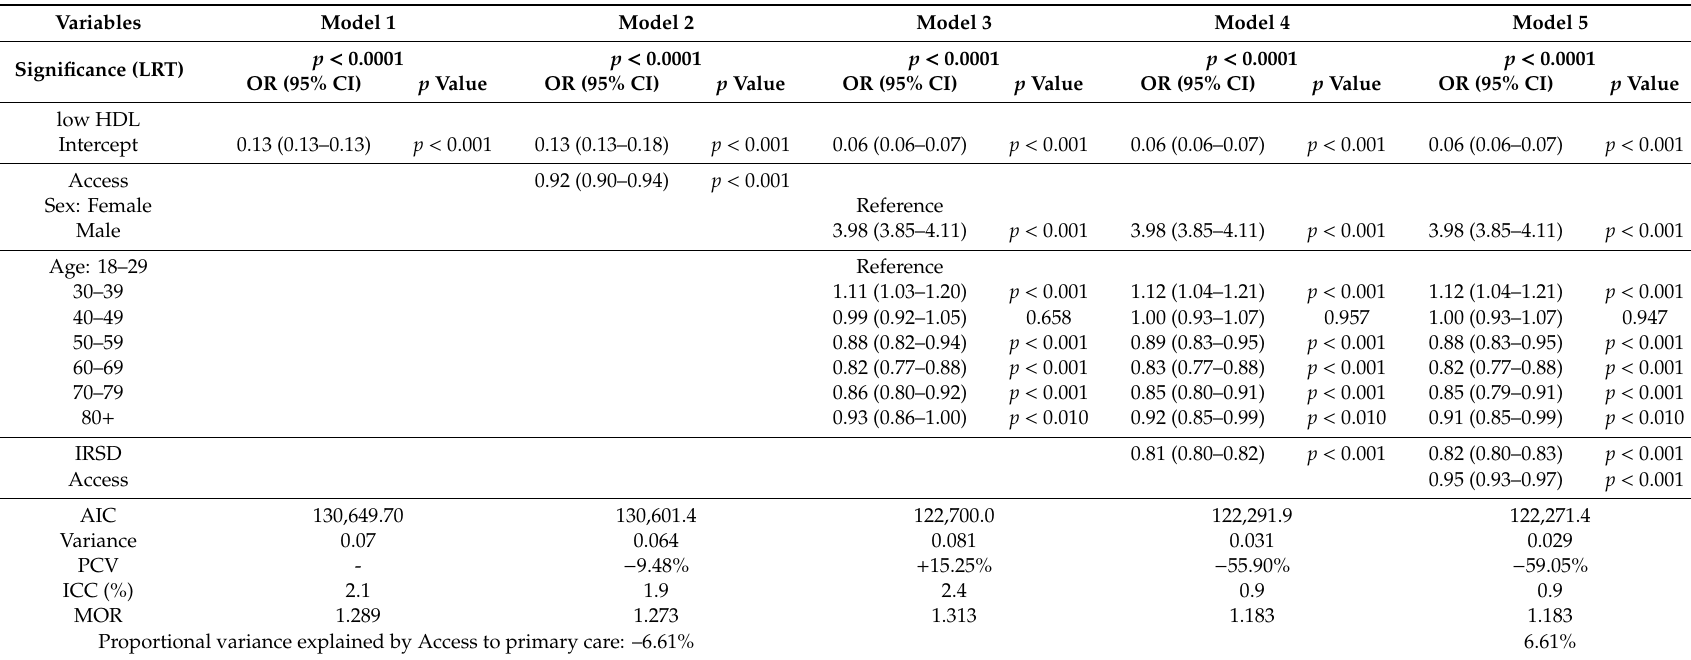
Table 6. Multilevel logistic regression model summaries of low HDL ( < 1 mmol /